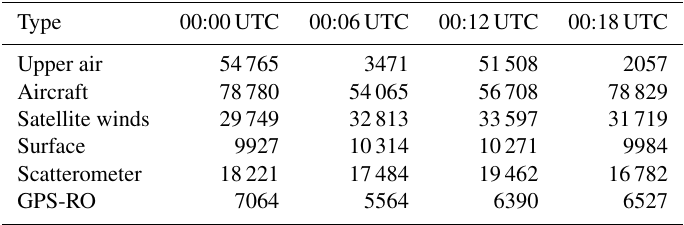
Table 1. Columns shows the typical number of meteorological observations assimilated in each 6h DA cycle.